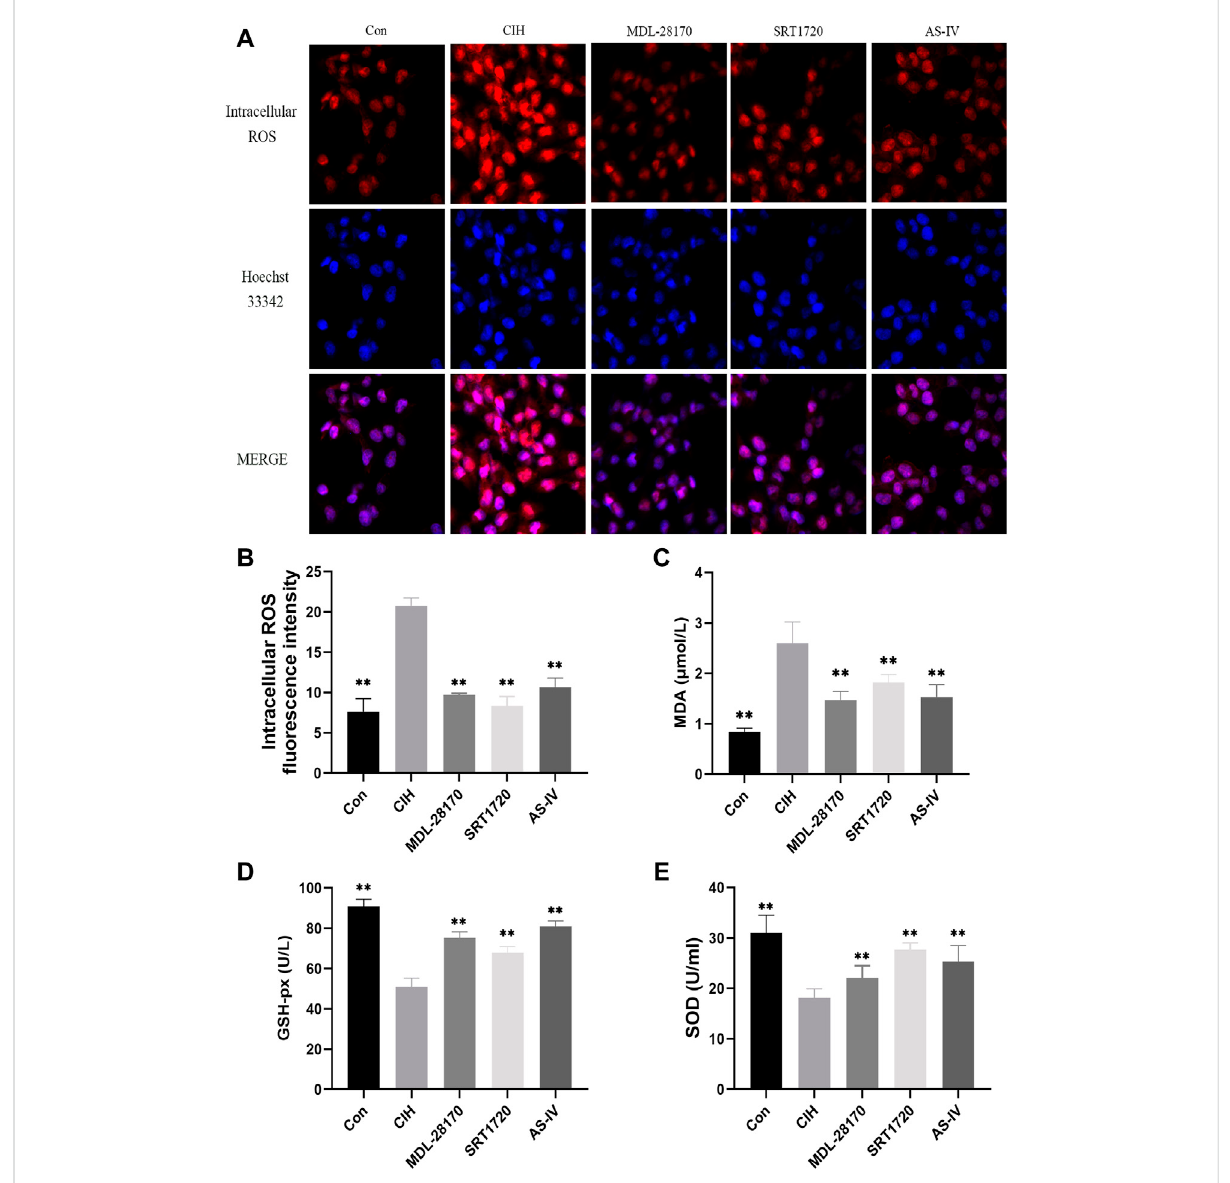
FIGURE 6 Effects of As-IV, MDL-28170 and SRT1720 on oxidative stress in HCAECs exposed to CIH. (A,B) Representative fl uorescence images and fl uorescenceintensityofintracellularROSinHCAECsofdifferentgroups(×200magni fi cation; n =3).DHEdye(red),Hoechst33342(blue). (C – E) The activity of SOD and the levels of MDA and GSH-px in HCAEC supernatant were detected using kits ( n = 8). Data are presented as means ± SD. ** p < 0.01, vs. CIH